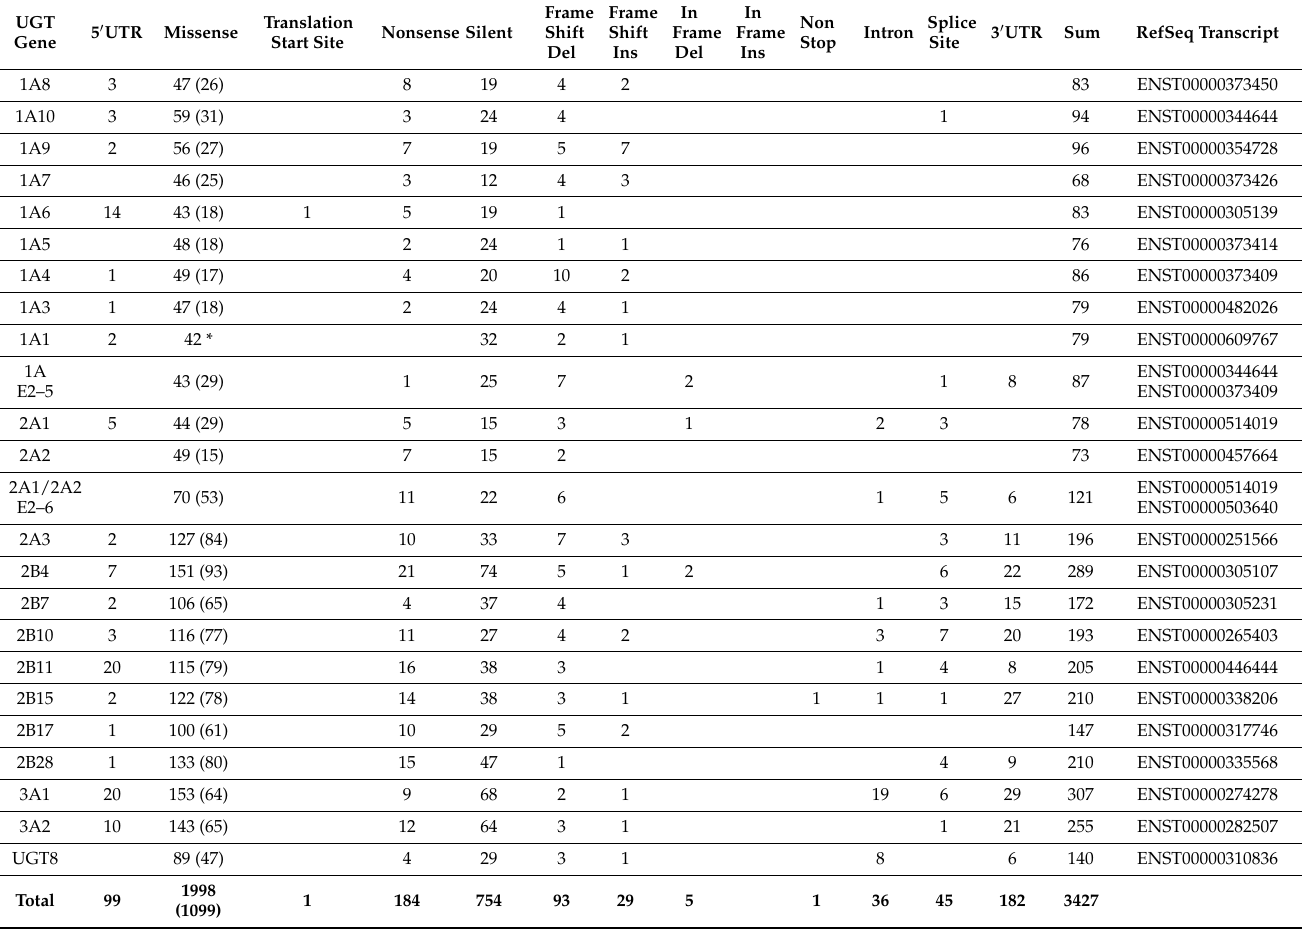
Table 2. Somatic mutations for each of the 22 UGT genes in TCGA